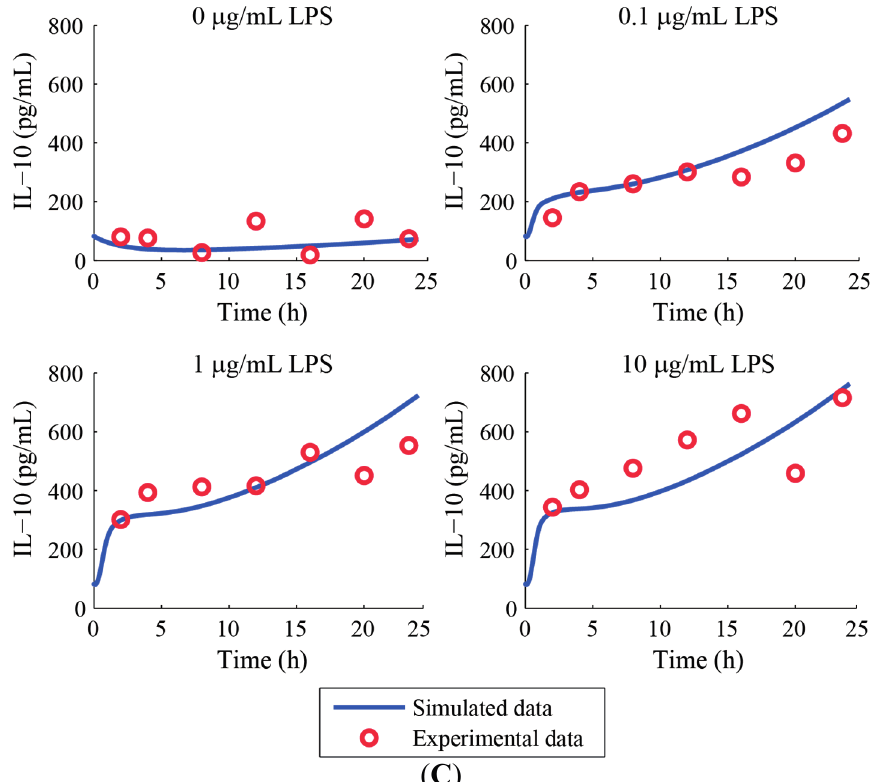
Figure 5. Comparison of model predictions and experimental data for LPS-stimulated RAW264.7 macrophages. ( A ) Phosphorylated NF- κ B/Total NF- κ B in